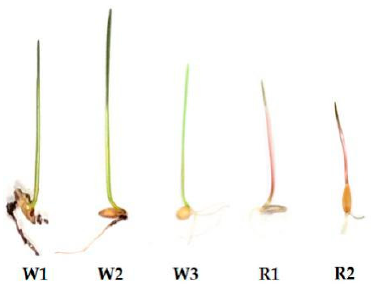
Figure 1. The coleoptiles of PI190939 (W1), CItr13961 (W2), CItr13962 (W3), PI554495 (R1), and PI554500 (R2).